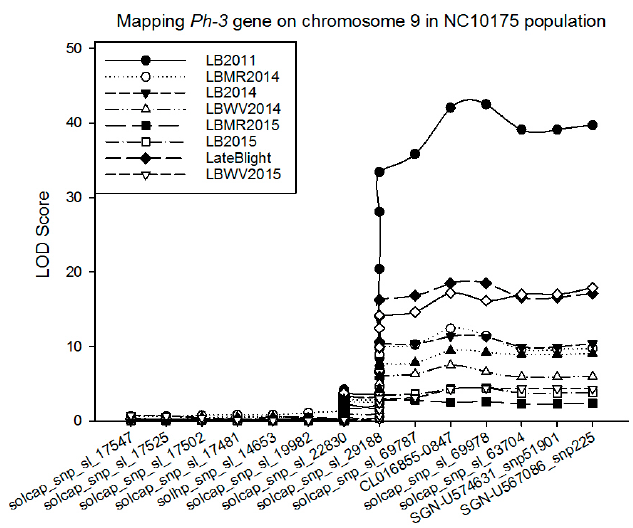
Figure 2. Mapping Ph-3 on chromosome 9 in segregating tomato population derived from an intra-specific cross. Molecular markers and its position information is given in Table 3. LB2011 = Late blight trial conducted in 2011; LBMR2014 = Late blight trial conducted at MHCREC at Mills River in 2014; LBWV2014 = Late blight trial conducted at MRS, Waynesville, NC in 2014; LB2014 = Average late blight data from MHCREC and MRS in 2014; LBMR2015 = Late blight trial conducted at MHCREC at Mills River in 2015; LBWV2015 = Late blight trial conducted at MRS, Waynesville, NC in 2015; LB2015 = Average late blight data from MHCREC and MRS in 2015. Y -axis shows the LOD score and X -axis shows the marker labels.